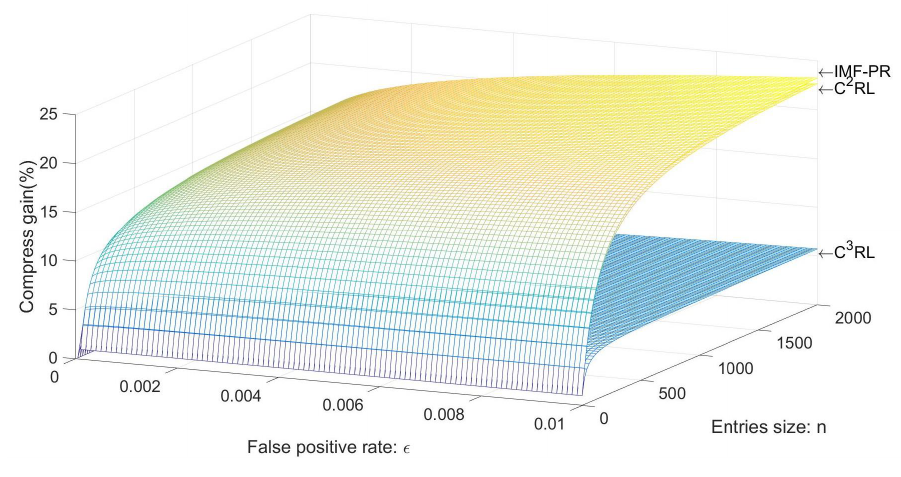
Figure 9. Compression gain ( α = 0.5).